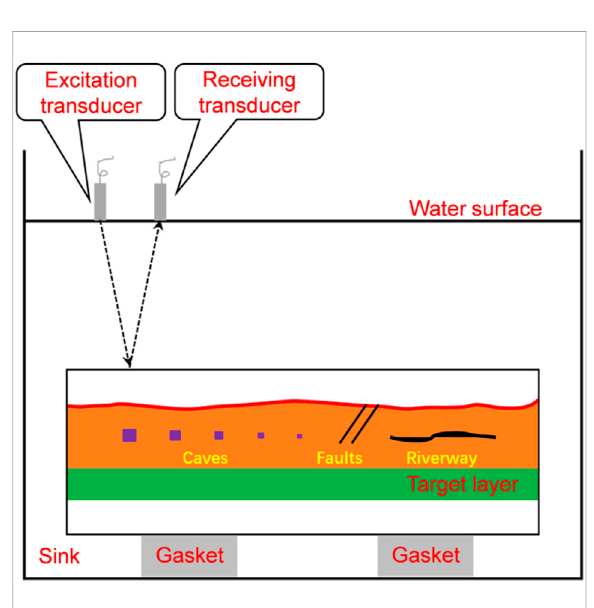
FIGURE 11 The physical simulated model, and ultrasonic data excitation and collection